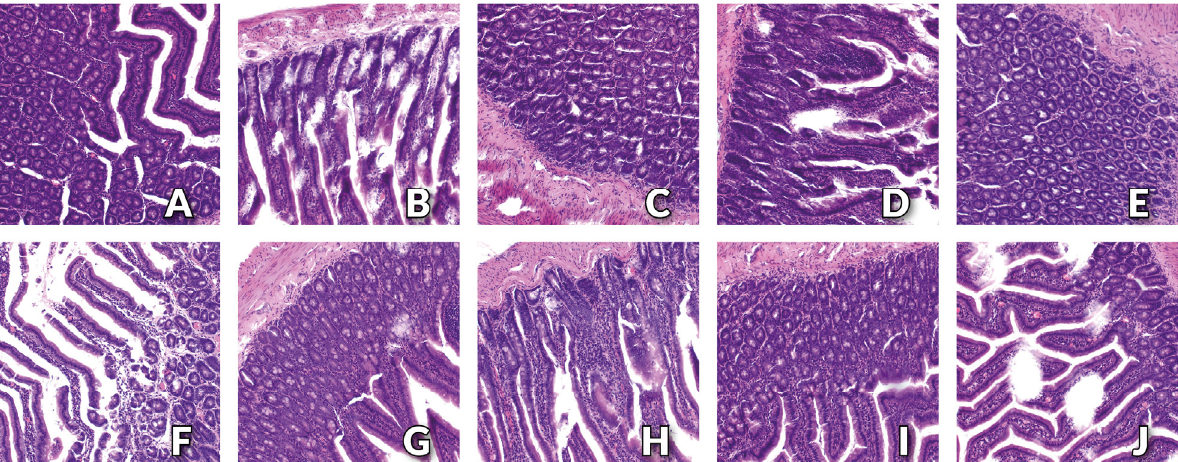
Figure 1. Morphological effects of different Cu sources (CuCO 3 or CuNPs), CuNPs levels (L—6.5 mg Cu/kg diet or H—13.0 mg Cu/kg diet) or type of fibre ( C —cellulose, P—pectin, J—inulin or S— psyllium) in the diet on the small intestine of rats; 10 × magnification. Treatments: ( A )—C, ( B )—CH, ( C )—CN, ( D )—CNH, ( E )—PN, ( F )—PNH, ( G )—JN, ( H )—JNH, ( I )—SN, ( J )—SN.